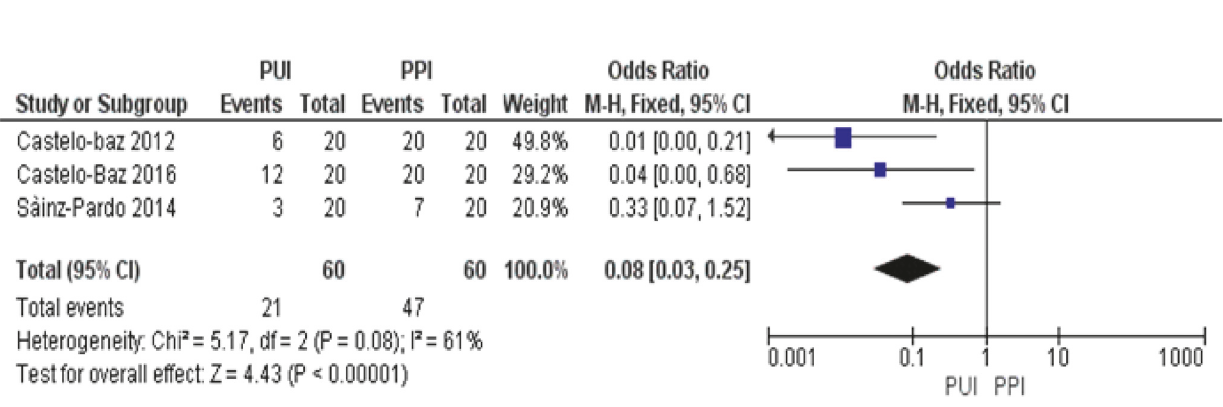
Figure 2: Results of risk of bias calculation between studies using Review Manager Software version 5.3, being illustrated with the help of forest plot